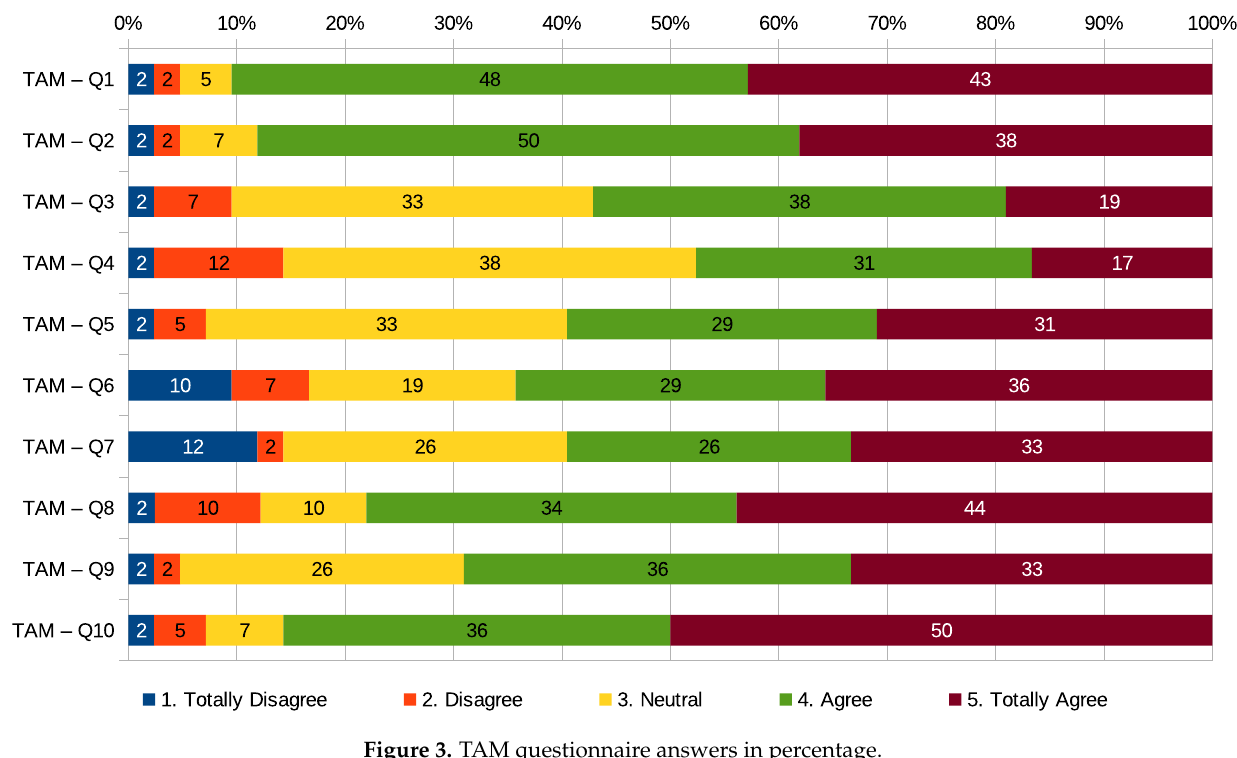
Figure 3. TAM questionnaire answers in percentage. Table 4. Frequentist Scale Reliability Statistics. PU: Perceived Usability, PEoU: Perceived Ease of Use, ATT: Attitude Towards Technology, AIC: Average Inter-item Correlation.